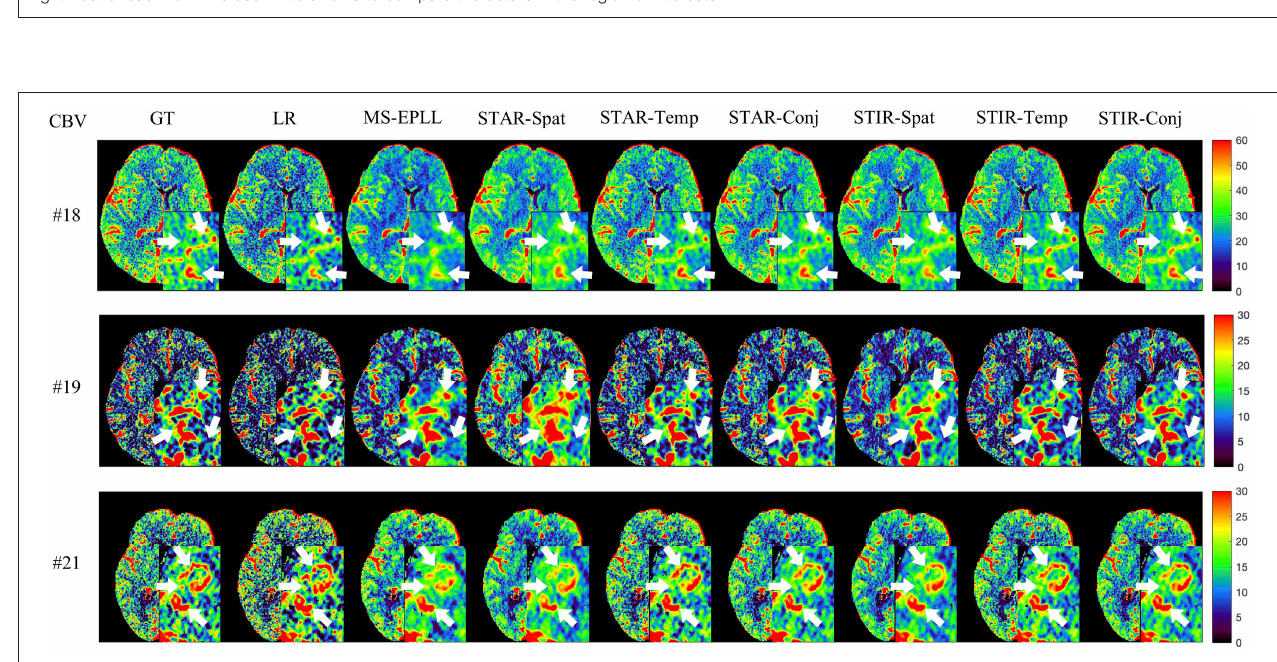
FIGURE 4 | Visual comparison of CBV for three test patients: #18, #19, and #21, when reducing the tube current to 40 mAs with a down-sample ratio of two (two times low spatial and two time low temporal resolutions). The notation for each column is: GT, Ground truth image; LR, Low-Resolution input; MS-EPLL, MS-EPLL restoration result; STAR-Spat, STAR reconstruction result (spatial only); STAR-Temp, STAR reconstruction result (temporal only); STAR-Conj, STAR reconstruction result (spatial + temporal); STIR-Spat, STIR-Net reconstruction result (spatial only); STIR-Temp, STIR-Net reconstruction result (temporal only); STIR-Conj, STIR-Net reconstruction result (spatial + temporal). All figures are displayed by using the same colormap and the color range for each patient is shown in the colorbar on the rightmost of each row. We use white arrows to compare the details in the region of interests.